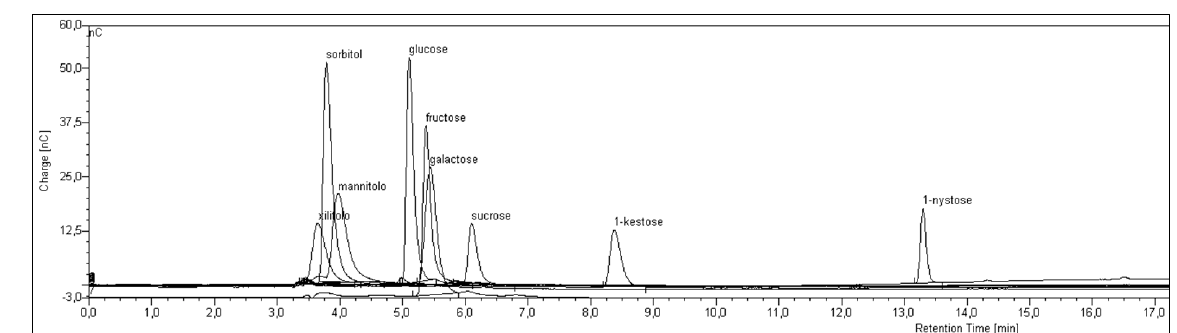
Figure A1. Overlap of standards chromatograms using CarboPac PA200 column.